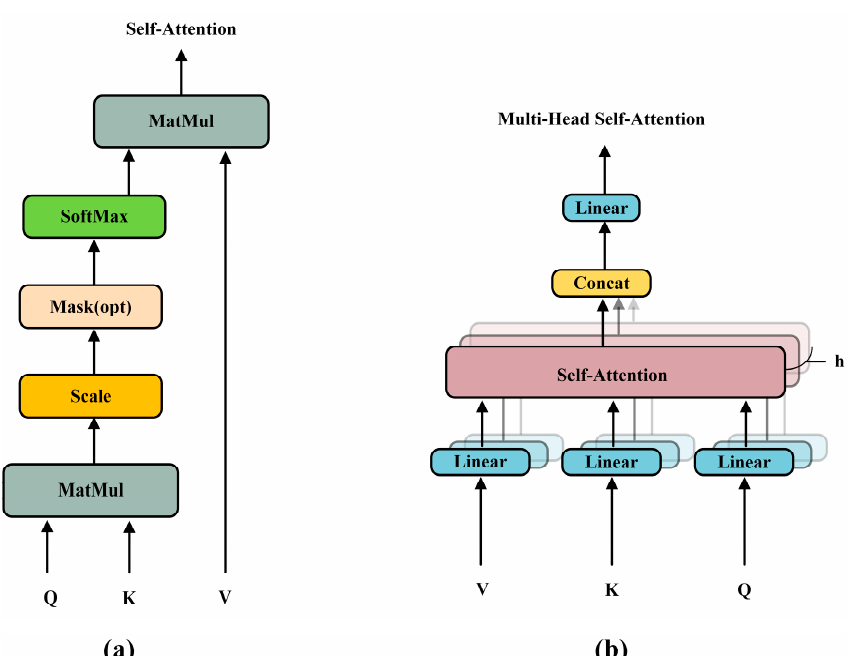
Figure 1. Transformer model structure.